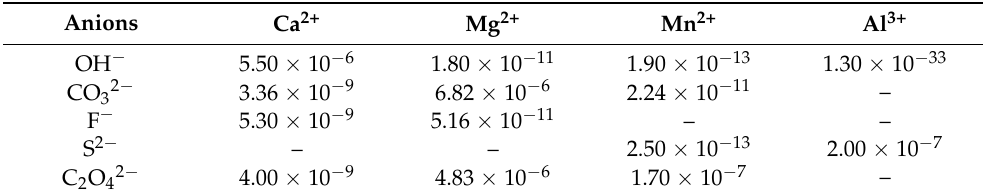
Table 2. Solubility product constants for common undissolved calcium, magnesium, manganese and aluminum compounds at 25 ◦